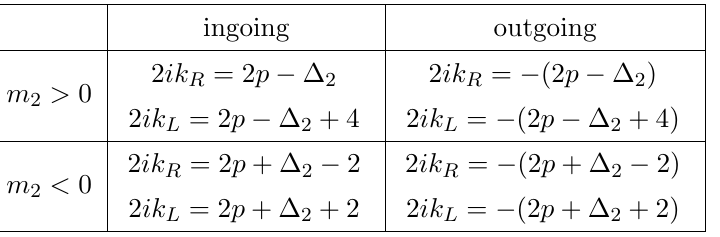
Table 4 . Spin-2 quasinormal mode spectrum after imposing chiral boundary conditions. When (cid:1) 2 = 2 these correspond to the symmetric, transverse, traceless graviton spectrum. Each condition on k R or k L labels a distinct eigenmode and the range of p is over all non-negative integers. m > 0 m 2 2 p + 2 (cid:0) (cid:1) + j n (cid:0) 2 j + ik ( n; k ) = 0 2 (cid:8)